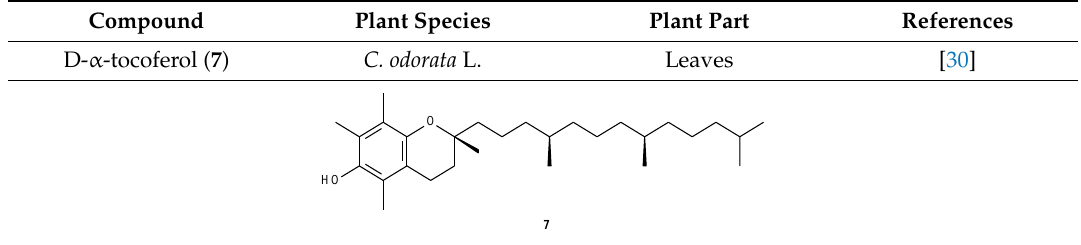
Table 4. Monoterpenes identified from the genus Cedrela (1960–2020).